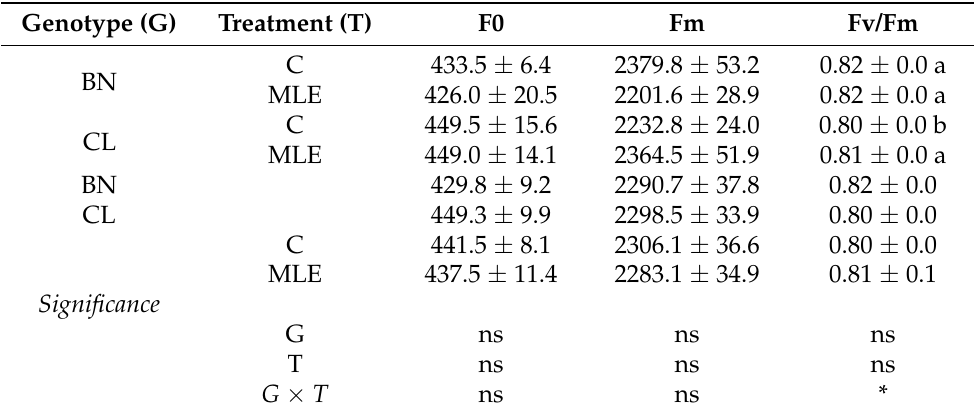
Table 2. Effect of moringa leaf extract (MLE) application on minimum fluorescence (F0), maximal fluorescence (Fm) and maximal quantum yield of PSII photochemistry (Fv/Fm) on plant of Broccoli Nero (BN) and Cavolo Laciniato Nero di Toscana (CL). MLE extract was sprayed 15, 30 and 43 days after